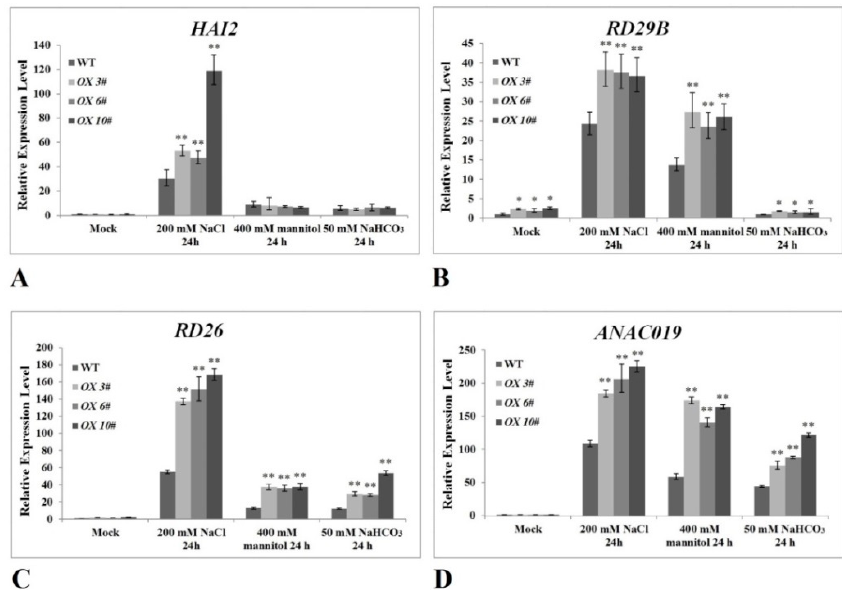
Figure 8. Analysis of the expression levels of stress-responsive genes in CrPIP2;3 transgenic lines ( CrPIP2;3 OX 3# , OX 6# , and OX 10# ) and WT plants under normal and salt/alkali/osmotic conditions based on qRT-PCR. ( A ) HAI2 ; ( B ) RD29B ; ( C ) RD26; and ( D ) ANAC019 . Error bars indicate the ± SD based on three replicates. Asterisks indicate significant differences from the WT (control, Student’s t test, * P < 0.05 and * * P < 0.01).